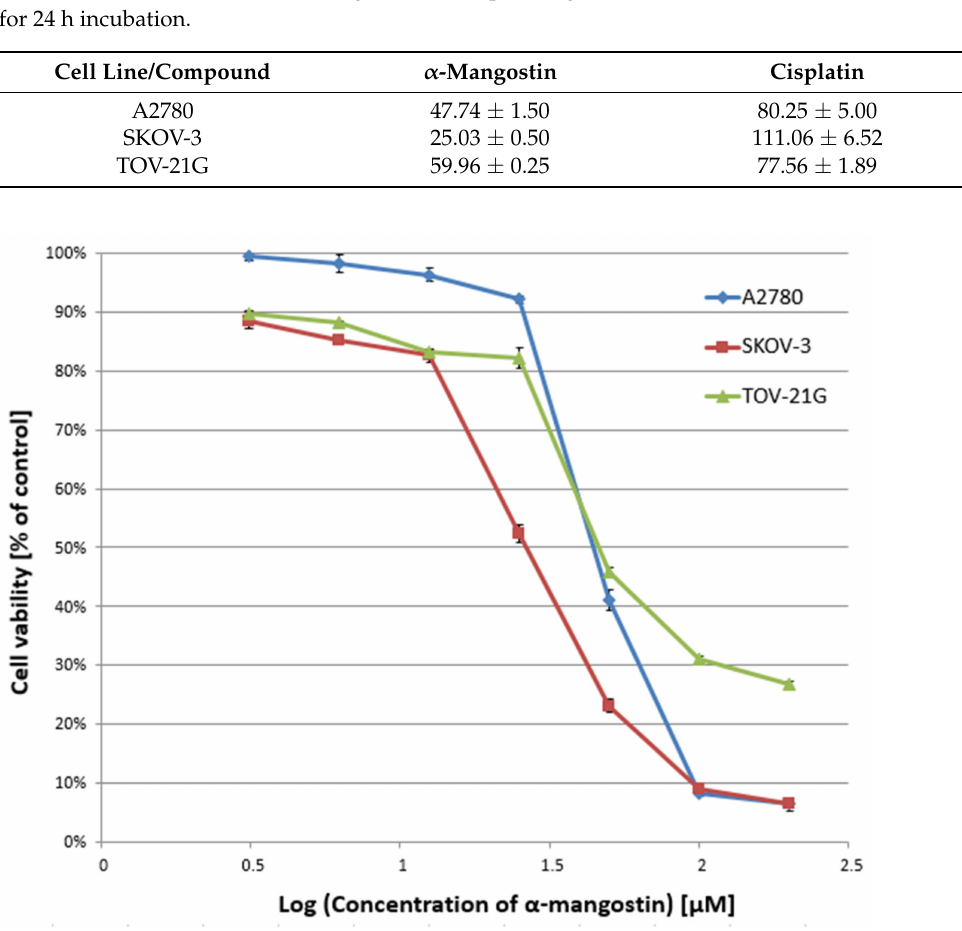
SD of triplicate ±